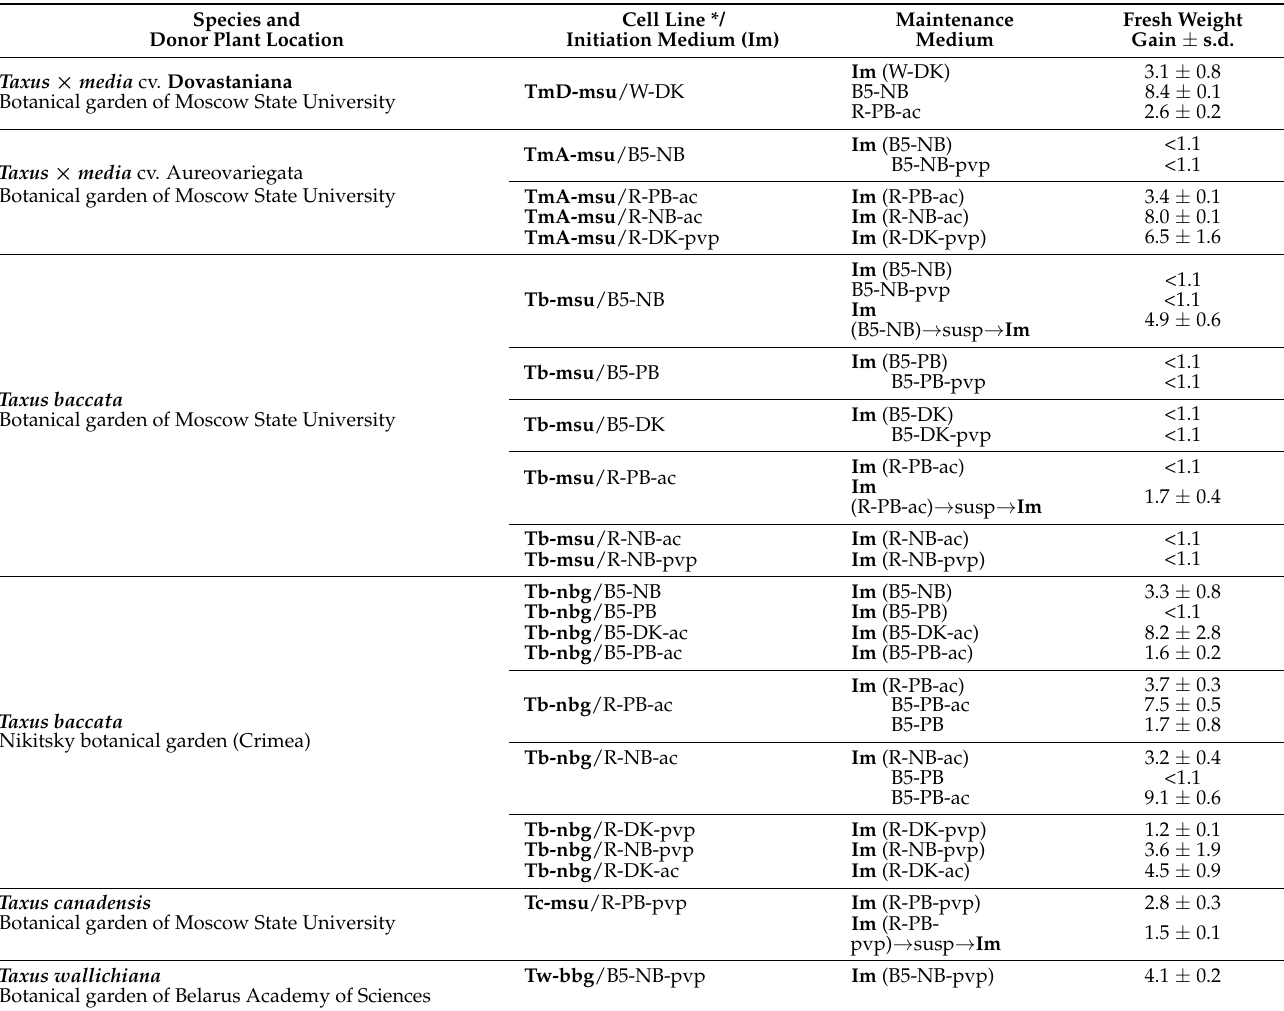
Table 1. Callus cell cultures of Taxus spp. with nutrient media used for their initiation and mainte- nance, and increase in fresh weight.